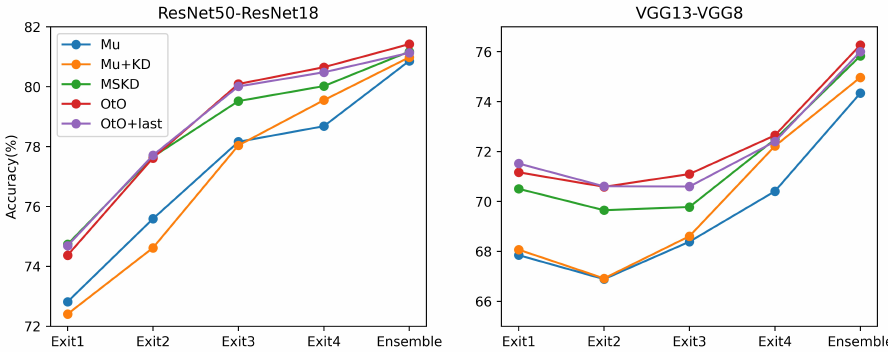
Figure 6. Comparison of the accuracies of different methods for multiple exits on CIFAR100.